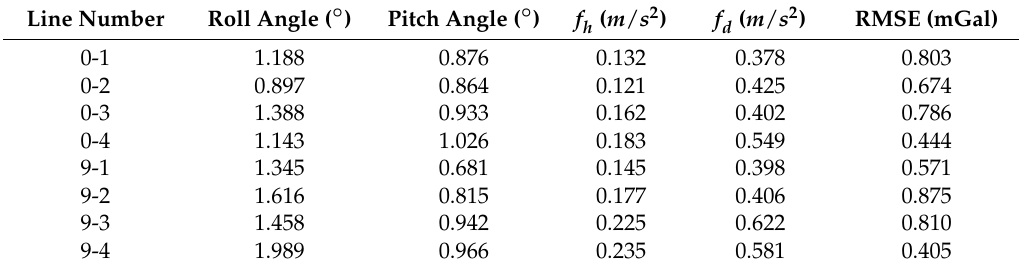
Table 4. Standard deviation of four factors and internal RMSE in two repeat line flight.